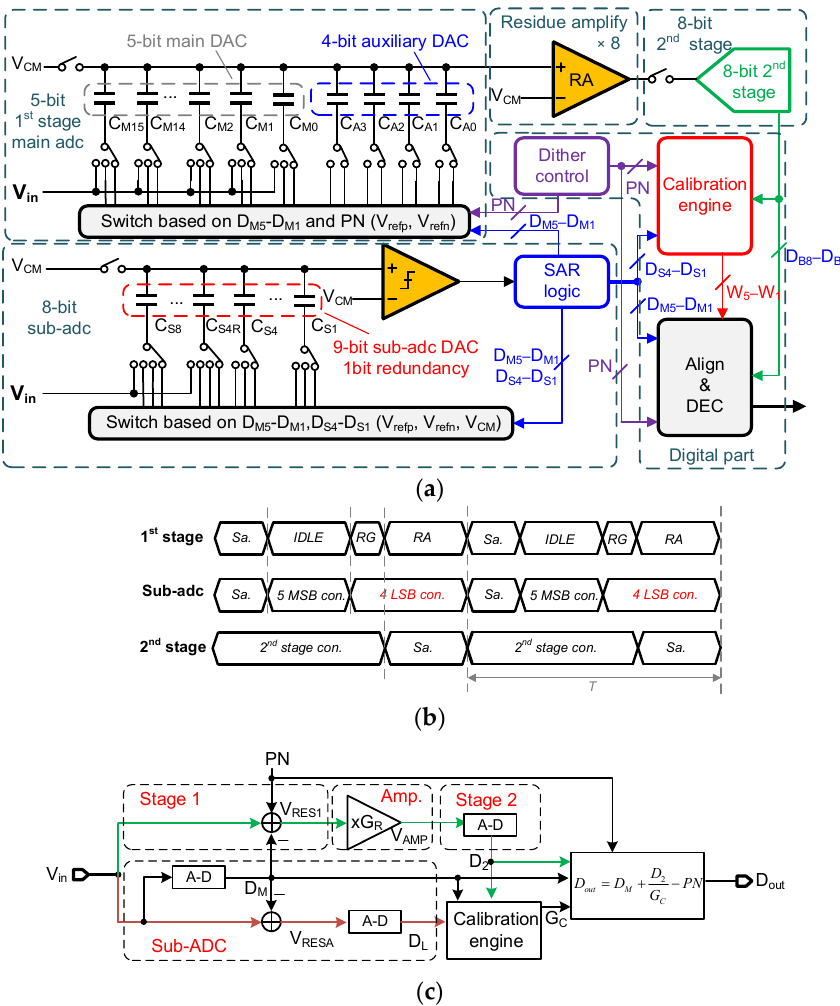
Figure 1. ( a ) Block diagram, ( b ) timing diagram and ( c ) simplified signal flow diagram of the proposed pipeline ‐ SAR ADC.